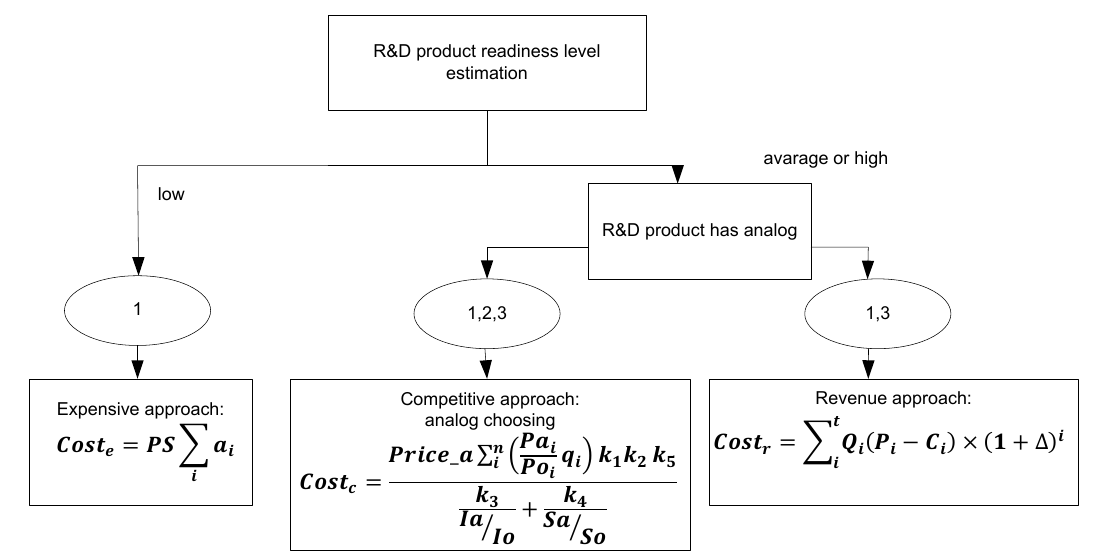
Figure 4. The proposed algorithmic realization of R&D products’ cost estimation method.